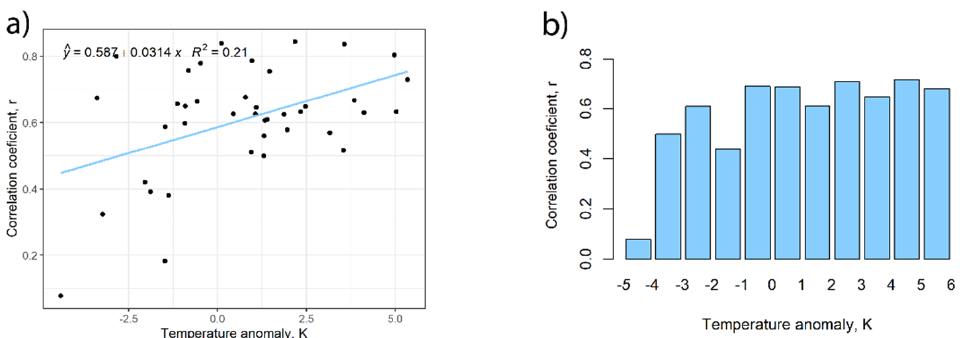
Figure 3. The scatter plot with regression line ( a ) shows the magnitude of the Pearson’s correlation coefficient between ↑ EPz m (30km), and the polar cap air temperature at 10 hPa vs the mean NDJF temperature (10 hPa, 60–90 ◦ N) anomaly (K) for each year; and histogram ( b ) shows the distribution of averaged correlation coefficient within different stratosphere temperature (10 hPa, 60–90 ◦ N) anomaly (K) intervals.